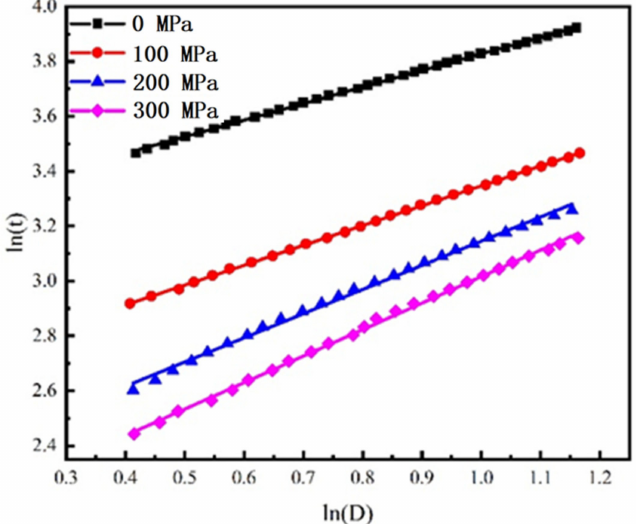
Figure 9. ln ( t ) vs. ln ( D ) curves under different pressures during the isothermal-solidification